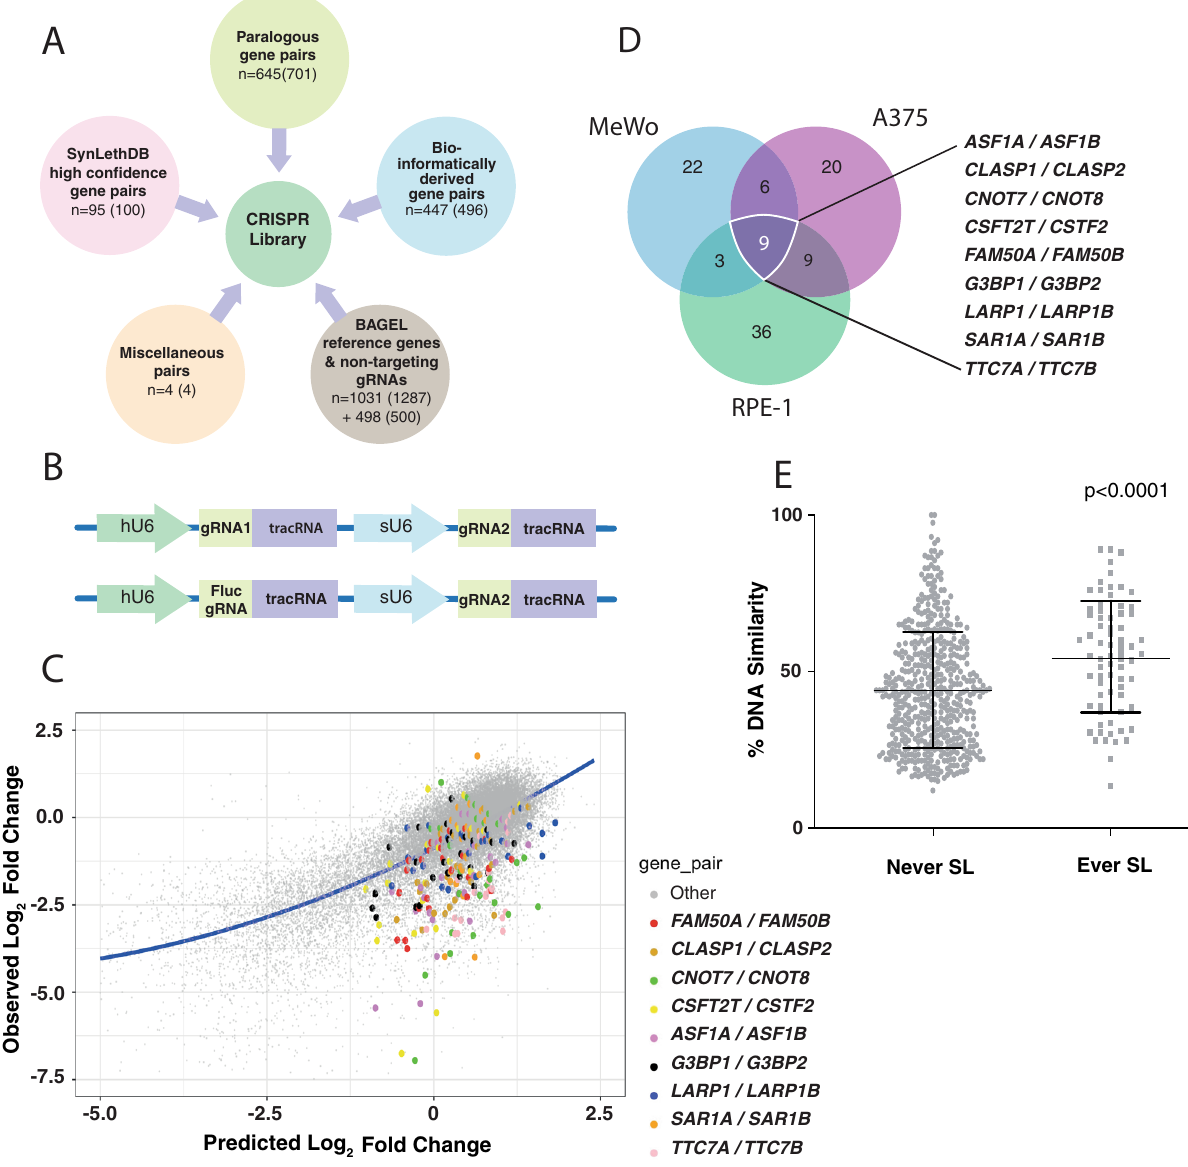
Fig. 1 Combinatorial CRISPR screen for cancer targets. A Schematic of the genes and gene pairs included in the paired gRNA library. The number of gene pairs for which the minimum guide number could be identi fi ed with our gRNA selection criteria is shown. The number in brackets is the total number of pairs in each category. B Design of the multiplex gRNA construct. To assess single-guide activity, a non-targeting gRNA ( Fluc ) was placed under the hU6 promoter and the gRNA against the candidate gene was placed under the sU6 promoter. To assess paired gene activity, all fi ve gRNAs for one gene were under the hU6 promoter, whereas the guides targeting the other gene were under the sU6 promoter. C Derivation of residual values. The predicted log 2 -fold change (FC) of the paired construct was calculated from the sum of the growth phenotypes of individual guides and the observed (experimentally determined) log 2 FC was the actual behaviour of the pair in the screen. The behaviour of the population was modelled using Loess smoothing (blue line). The residual was calculated as the vertical difference of any given point to the blue line. The more negative the residual, the more lethal the pair in the screen. The behaviour of the gRNA pairs for the nine synthetic lethal interactions common to all cell lines is shown in the A375 cell line. D Overlap between the synthetic lethal pairs identi fi ed in the screen in each of the three cell lines at Day 28. Signi fi cant gene pairs were de fi ned as having a signi fi cantly more lethal pairwise effect on cellular fi tness than expected from the effect of each individual gene (see Methods). Pairs where one of the genes was found to be lethal in isolation at Day 14 were excluded. E Percentage DNA sequence similarity between paralogues in our screen, identi fi ed as synthetic lethal in ≥ 1 cell line (Ever SL) vs zero cell lines (Never SL). Error bars show mean and standard deviation (SD) with each data point representing the average sequence similarity between paralogue pairs (see Source Data). The p value was determined using the two-tailed Mann – Whitney